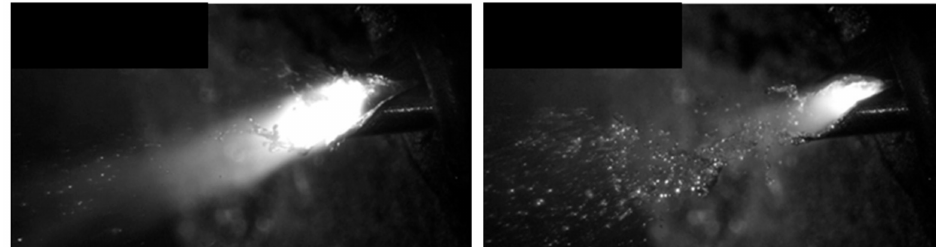
Figure 6. Particle formation during wire arc spraying with pulsed direct current at time ( left ): t = 12.6 ms, ( right ): t = 13.0 ms.